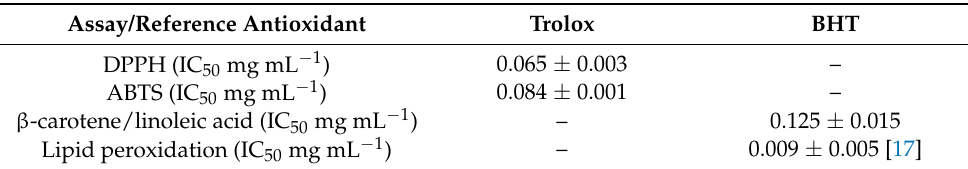
Table 4. Antioxidant activity of Trolox and BHT